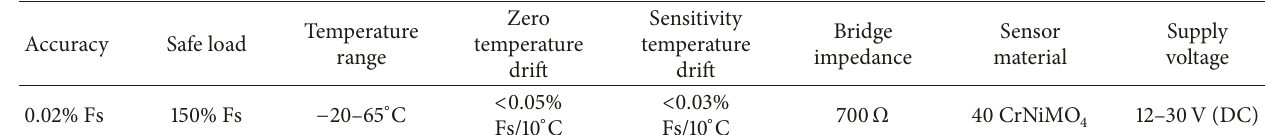
Table 5: Contact surface parameters of sensors employed in this study.